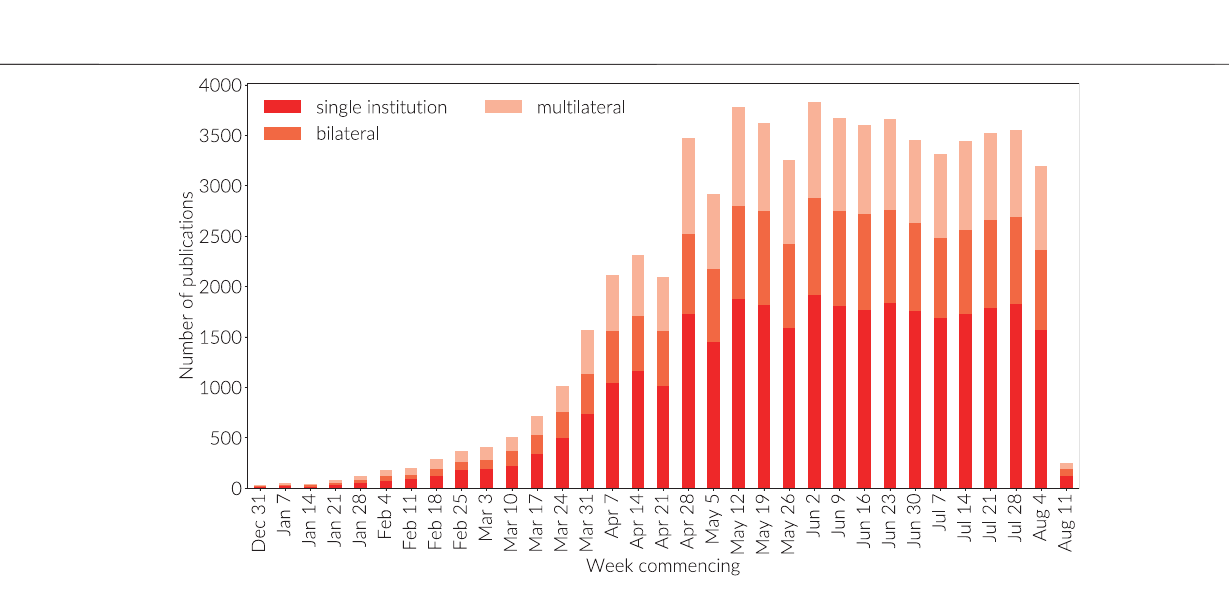
Frontiers in Research Metrics and Analytics |